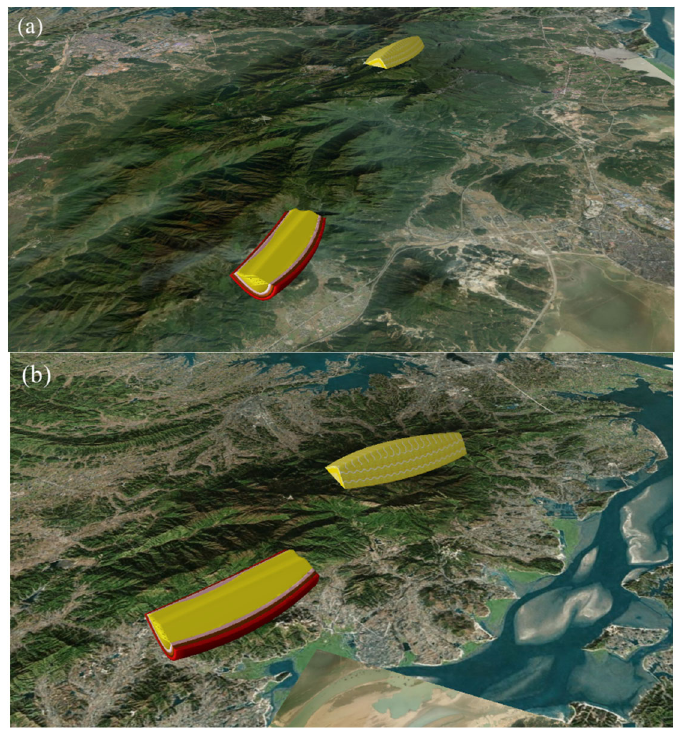
Figure 18. Display effect of fold symbols with different scaling ratios: ( a ) scaling down and ( b ) equal